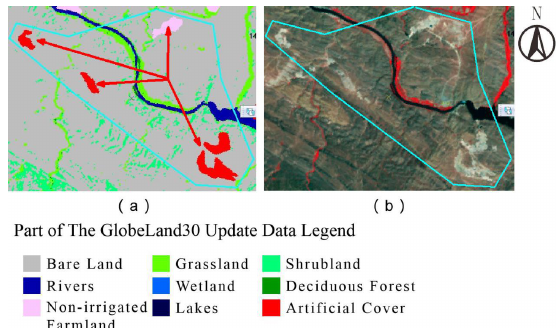
Figure 5. Lakes are misclassified as rivers （ The image used for data updating is superimposed together with GlobeLand30